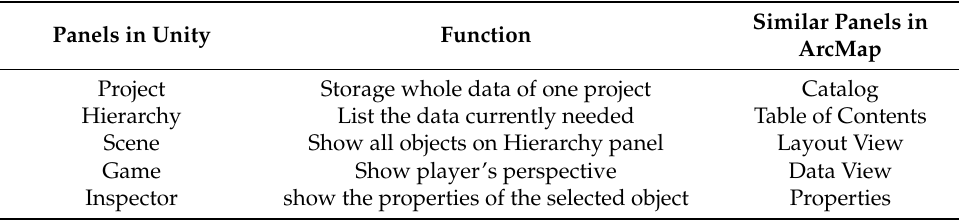
Table 1. Function introduction and similar panels in ArcMap of Panels in